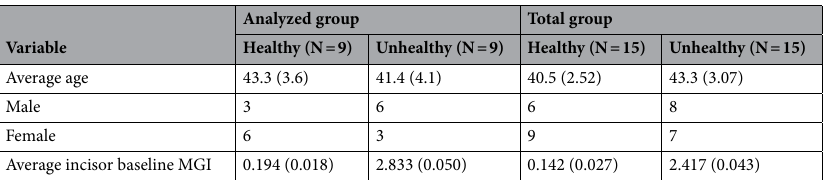
Table 1. Demographic data table of the subjects participating in the clinical study at baseline. Data are not representative of the full month MGI scores. The MGI scores capture the measurements from the upper and lower incisors (tooth # 7–10 and 23–26) and are expressed as mean (standard error of the mean) values. MGI modified gingival